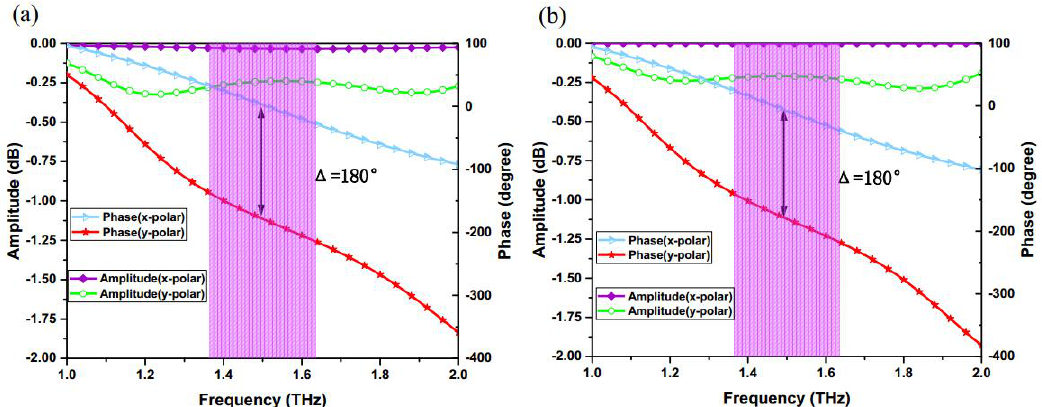
Figure 4. Reflection phases and reflection amplitudes of the proposed graphene element by using HFSS and CST: ( a ) the proposed graphene element achieves a 180° ± 10° reflective phase difference between x and y linearly polarized waves in the range of 1.36 ~ 1.62 THz, while reflective magnitudes are larger than −0.35 dB by using HFSS; ( b ) the proposed graphene element achieves a 180° ± 10° reflective phase difference between x and y linearly polarized waves, also in the range of 1.36 ~ 1.62 THz, but reflective magnitudes are large than −0.3 dB by using CST, and the reflection amplitude is a little larger than the amplitudes in HFSS.